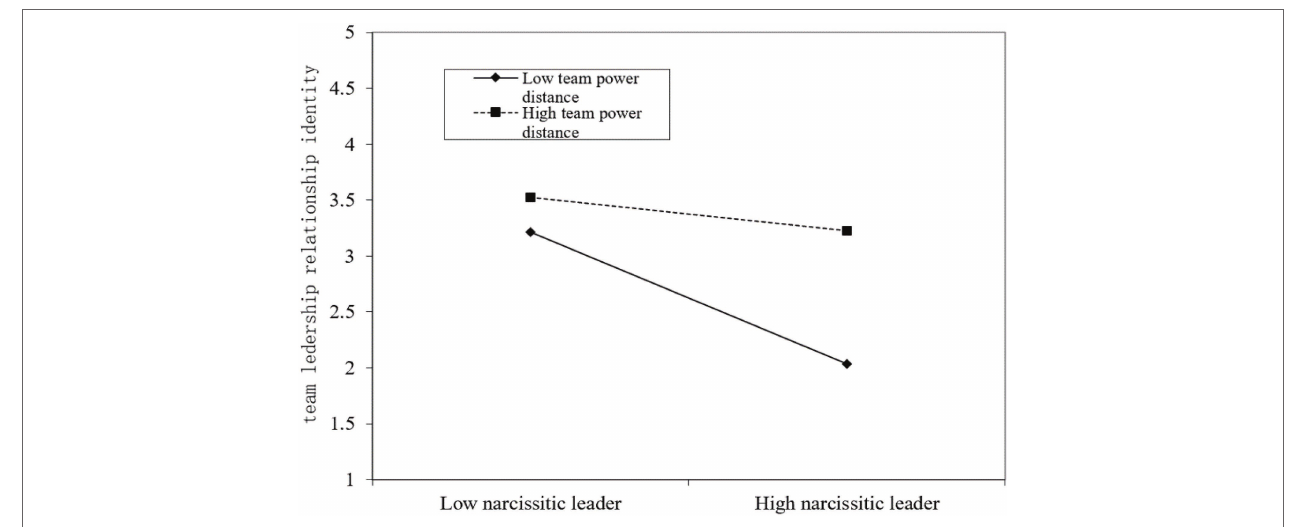
FIGURE 3 | Moderating effect of team power distance (PD).